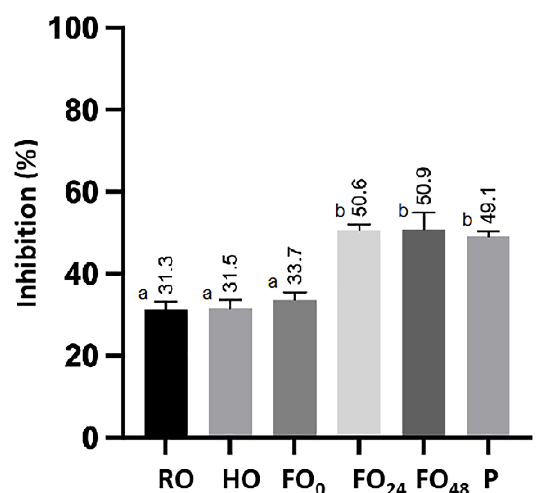
Figure 9. Tyrosinase inhibition ability of raw (RO), hydrolyzed (HO), and fermented oatmeal samples obtained at time 0, and after 24 h, 48 h, and deactivation process (FO 0 , FO 24 , FO 48 , and P, respectively) in solutions at fixed concentration (16 mg/mL). Each result represents the mean value of a triplicate analysis and error bars indicate the corresponding standard deviations. Values marked with different lowercase letters are significantly different ( p < 0.05), according to Tukey’s test .